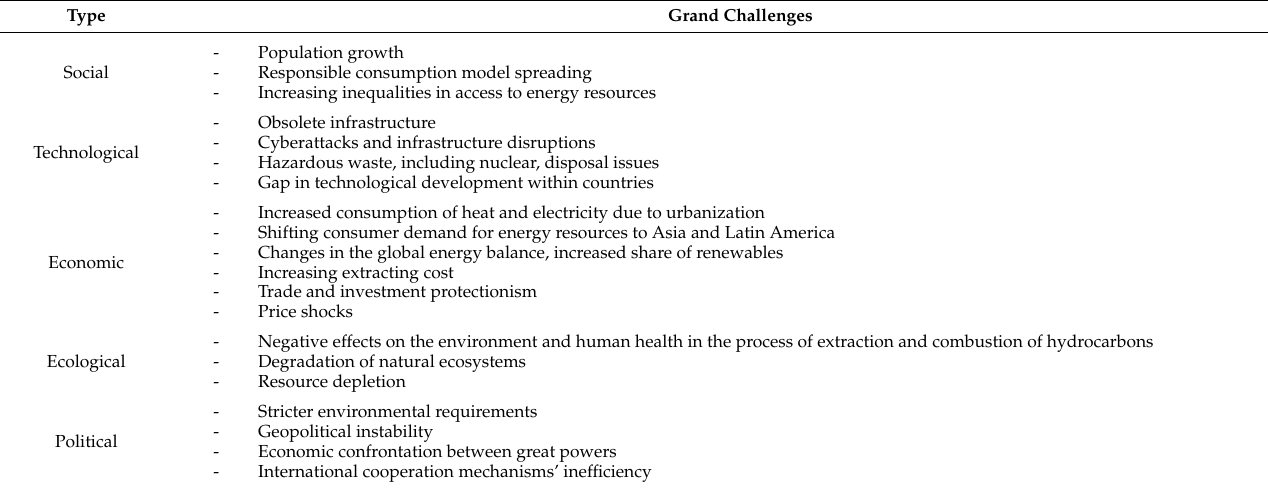
Table 1. Grand challenges for energy